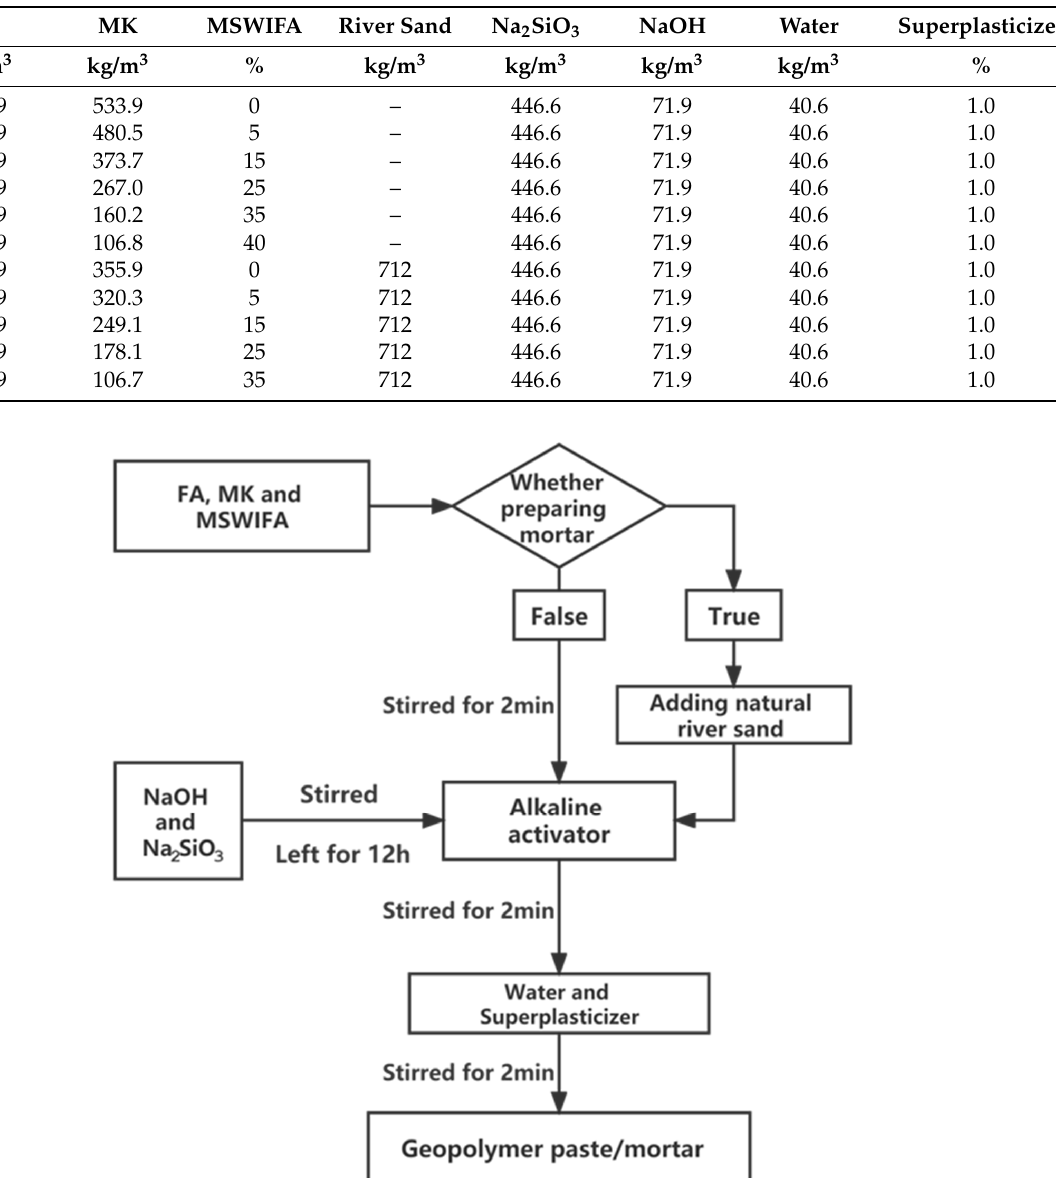
before the preparation of the geopolymer. The specific preparation process is shown in Figure 1. Specimens with dimensions of 100 mm × 100 mm × 100 mm were cast for the tests in this work. The specimens were demolded after hardening for 24 h in an indoor environment. Then, the specimens were placed in a standard curing room (temperature of 20 ± 2 ◦ C, relative humidity above 95%) for the target curing period. For the MIP and SEM tests, the curing period was 28 d, and the curing periods of the FT-IR tests were 3 d, 7 d, and 28 d. Table 2. Mix proportions of the geopolymer composites.